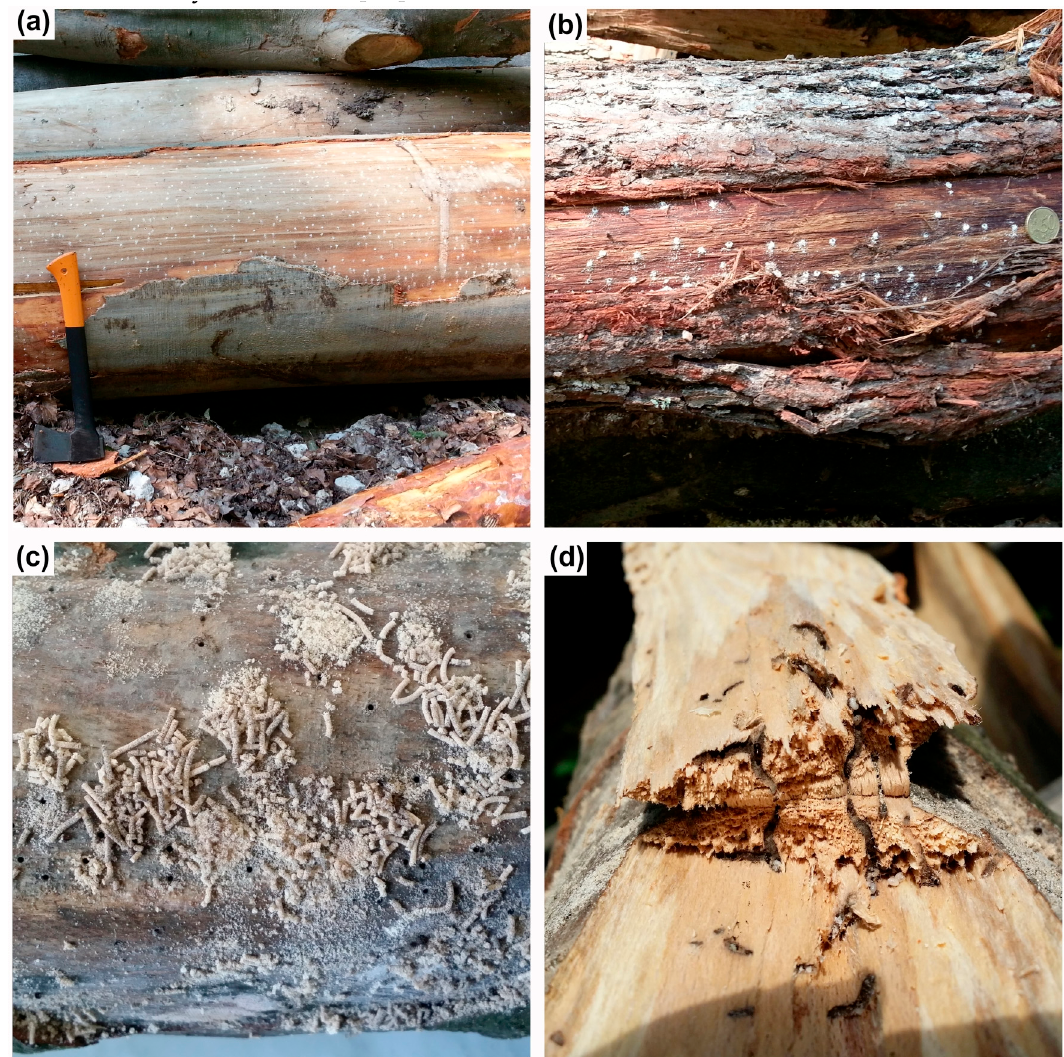
Figure 3. Fresh attacks (white sawdust) of Xylosandrus germanus on beech timber ( a ) and oak timber ( b ). After several weeks females expelled noodles of sawdust ( c ) from the gallery ( d ). Photo by Juraj Galko.